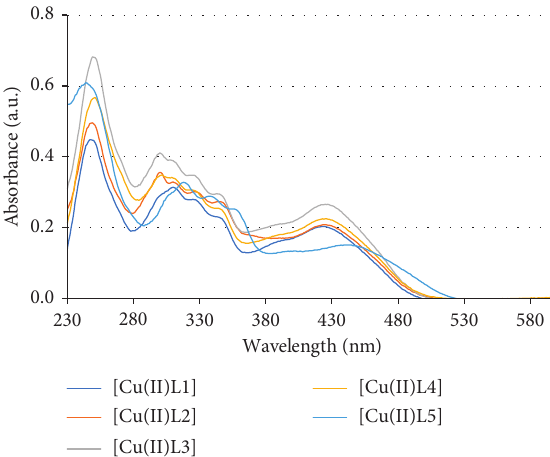
Figure 2: UV-Vis absorption spectra of unsymmetrical Schiff base Cu(II) complexes.